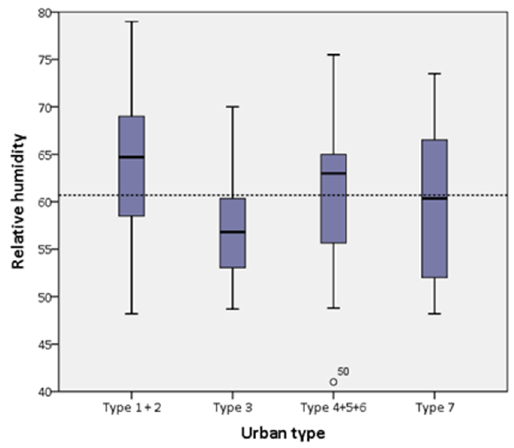
Figure 8. Distribution of relative humidity in different pattern type groups.